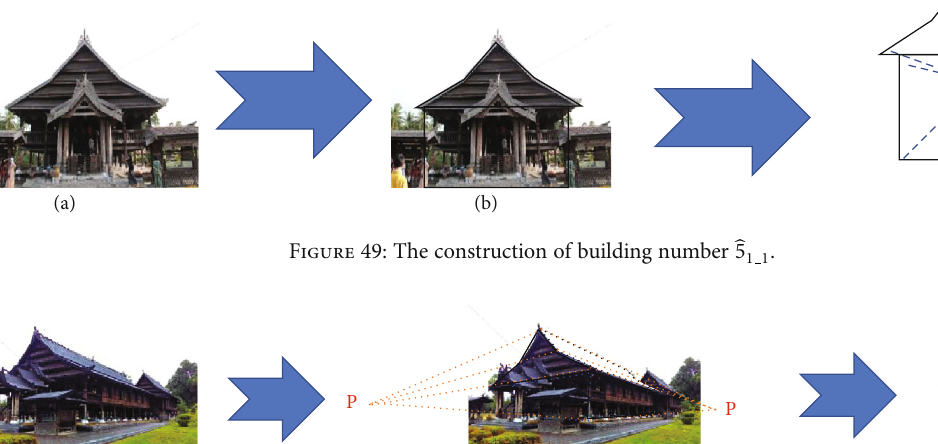
Figure 50: The construction of building number ̂ 5